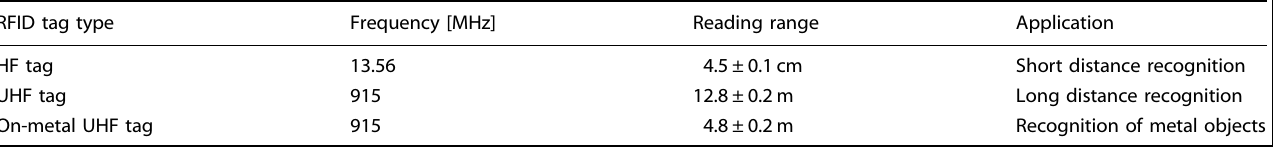
Table 1. Comparison of developed RFID tags fabricated with the antioxidant copper paste. RFID tag